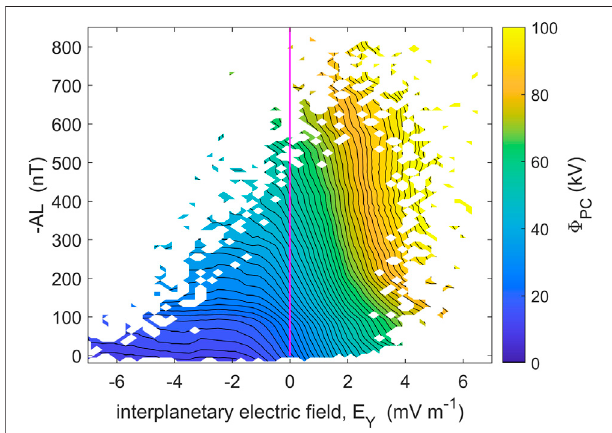
FIGURE3| Contoursofaveragetranspolarvoltage, Φ PC ,observedover 25 years by the northern hemisphere SuperDARN radar network (Lockwood and McWilliams, 2021a) as a function of the dawn-dusk interplanetary electric fi eld, E − AL Y , and the auroral electrojet index,